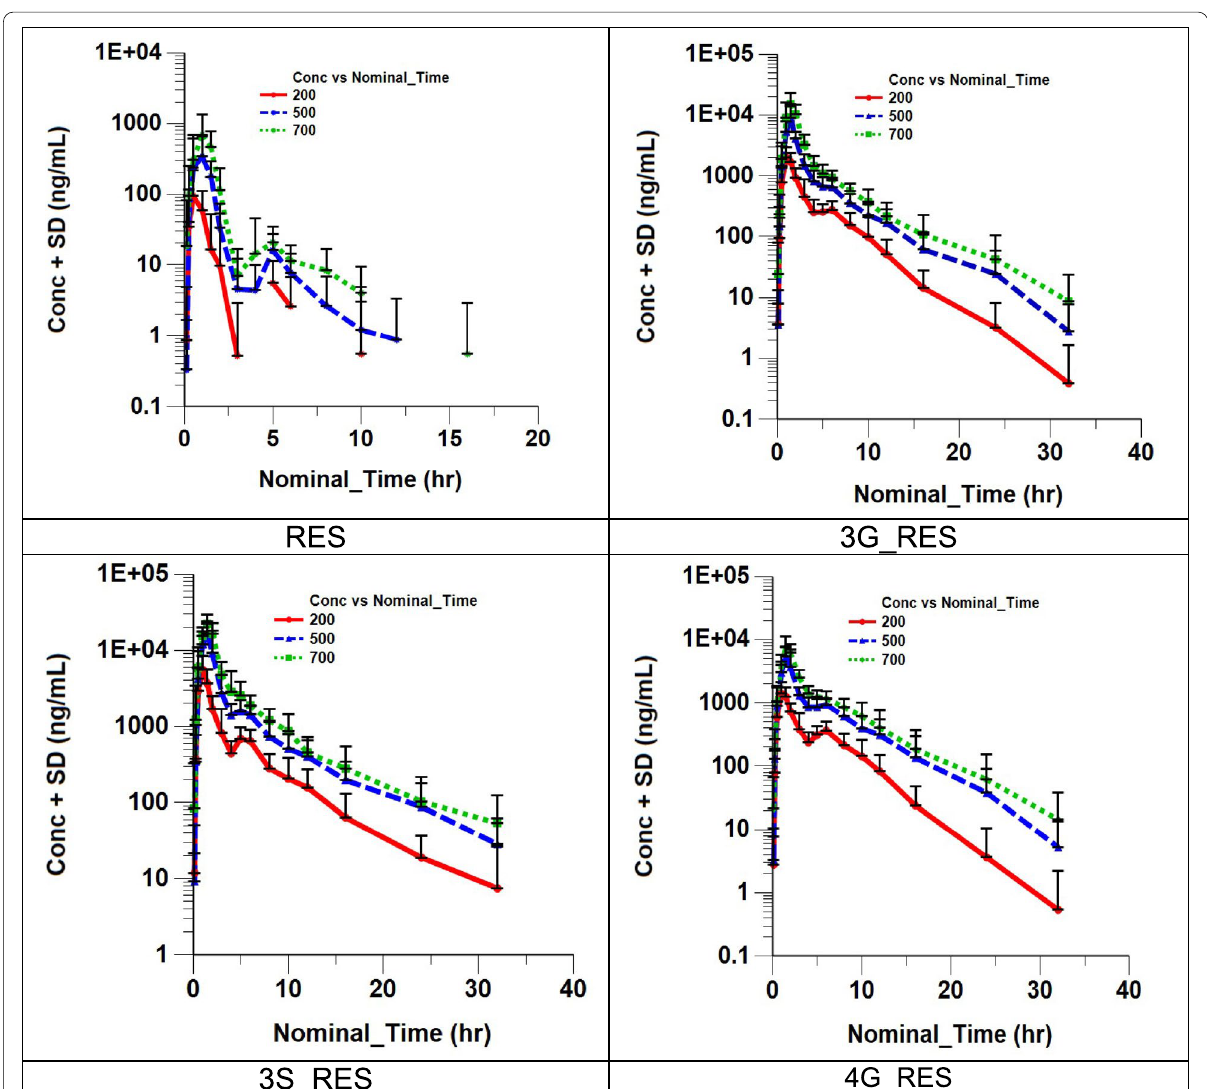
Fig. 2 Log‑linear concentration (ng/mL) vs. time plots of Resveratrol (RES) and its metabolites Resveratrol Sulfate (3S_RES), Resveratrol 3‑Glucuronide (3G_RES) and Resveratrol 4‑Glucuronide (4G_RES) in Human